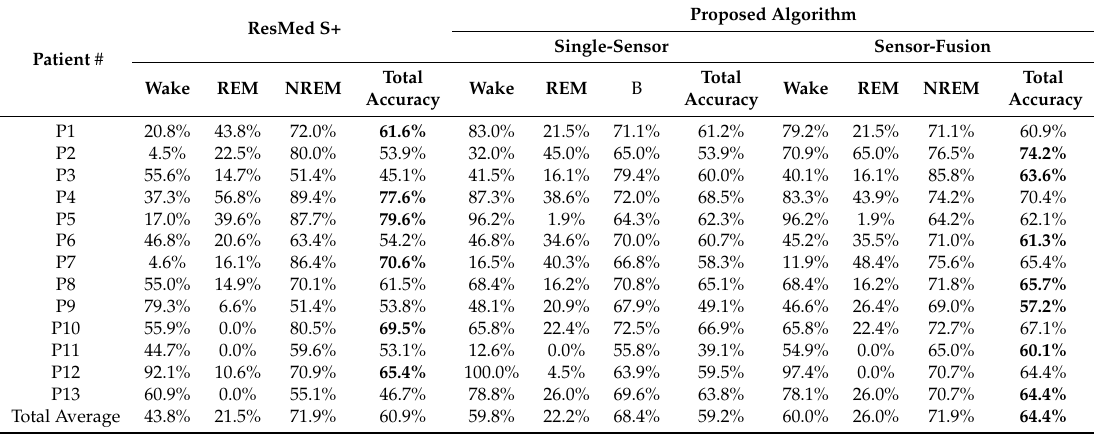
Table 2. Testing accuracy of comparative methods with the proposed sensor-fusion-based algorithm.